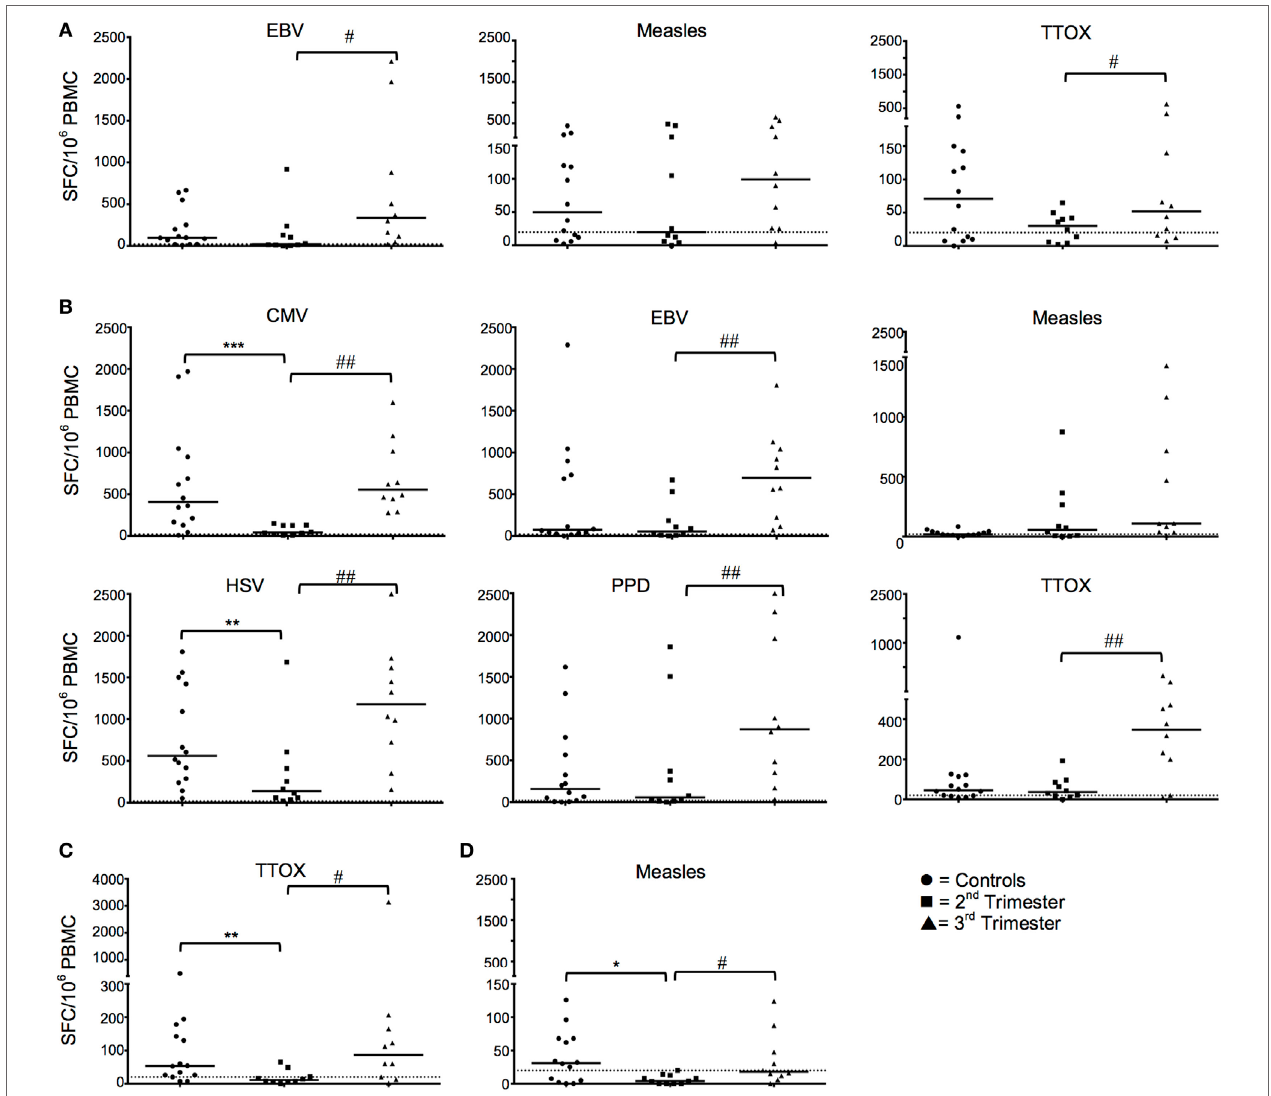
FigUre 1 | Longitudinal functional responses to recall antigens and peptides show dampened IFN- γ and IL-10 in the second trimester that revert in the third. (a) Shows numbers of IFN- γ producing cells in pregnancy in response to EBV, measles, and tetanus toxoid (TTOX), compared to healthy controls. (B) Likewise, panel B shows pregnancy trimester changes of IL-10 cellular responses to CMV, EBV, HSV, purified protein derivative (PPD), and TTOX, compared to non-pregnant controls. (c,D) Granzyme and IL-4 responses to TTOX and measles, respectively. ♯ p < 0.05, ♯♯ p < 0.01 (Wilcoxon matched-pairs signed ranks test); * p < 0.05, ** p < 0.01, *** p = 0.001 (Mann–Whitney- U ). Abbreviation: PBMC, peripheral blood mononuclear